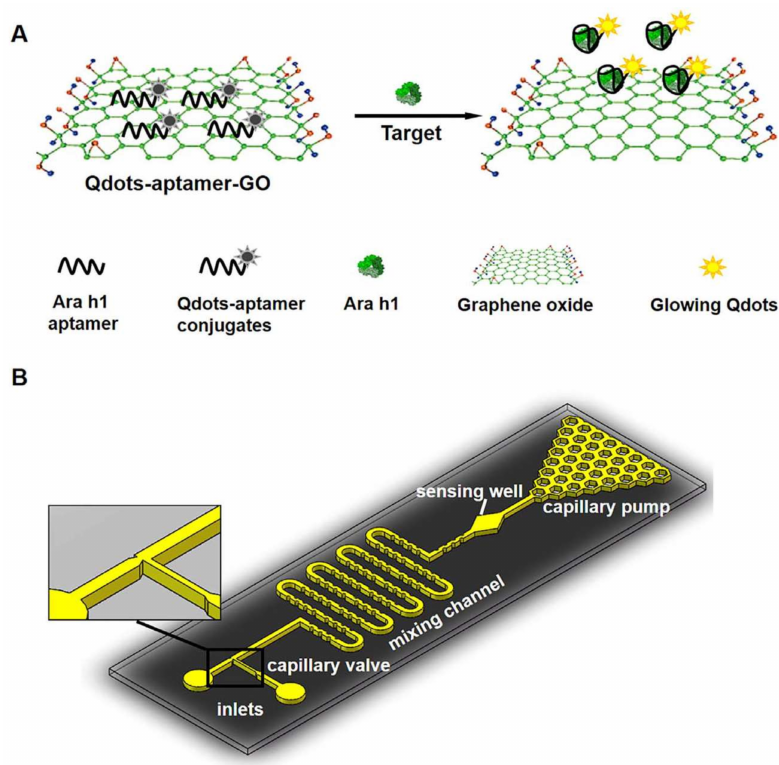
Figure 7. ( A ) Schematic of the sensing mechanism of the QDs-aptamer-GO quenching system; ( B ) Schematic diagram of microfluidic chip design (not to scale). The chip had two inlets for loading the QDs-aptamer-GO probe mixture and the Ara h1 sample, respectively. The main channel consisted of a mixing/incubation channel, a sensing well and a capillary pump at the end. The “diamond”-shaped well was the sensing well aligned to the sensing window of the Si photodiode. Reprinted with permission from [107]. Copyright 2018